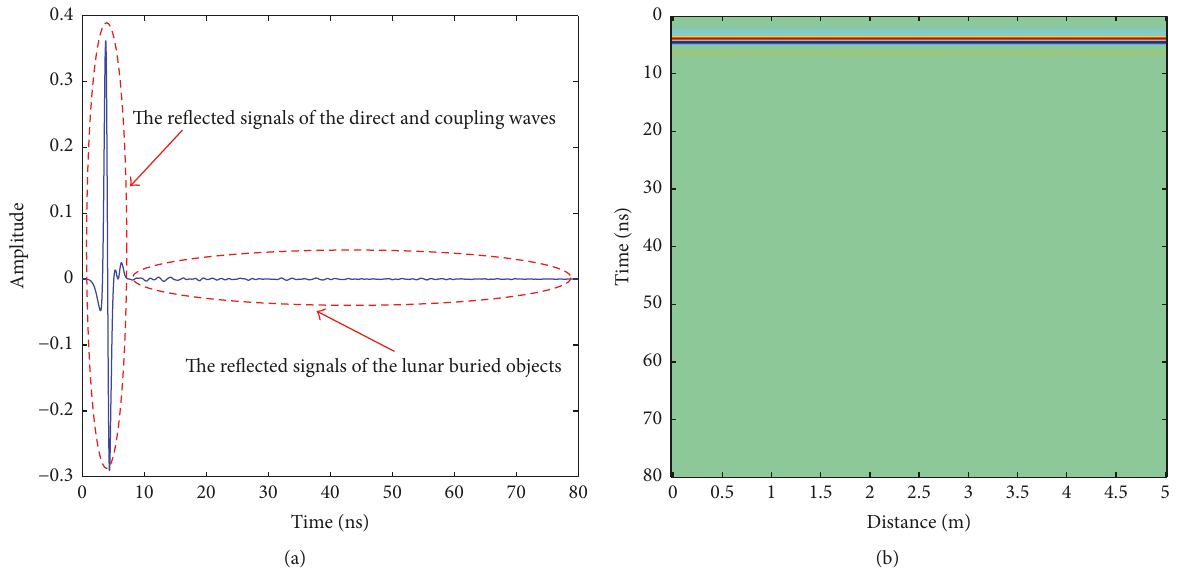
Figure 4: The simulation result of the random media model (a). The A-Scan of the simulated data is shown in (a). The B-Scan of the simulated data is shown in